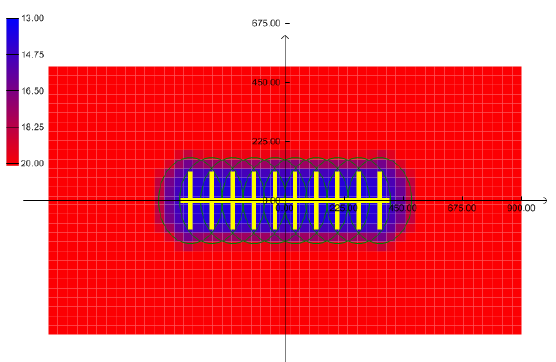
Figure 6. Comparison of the gas production rate of the model in this study and the CMG numerical model.